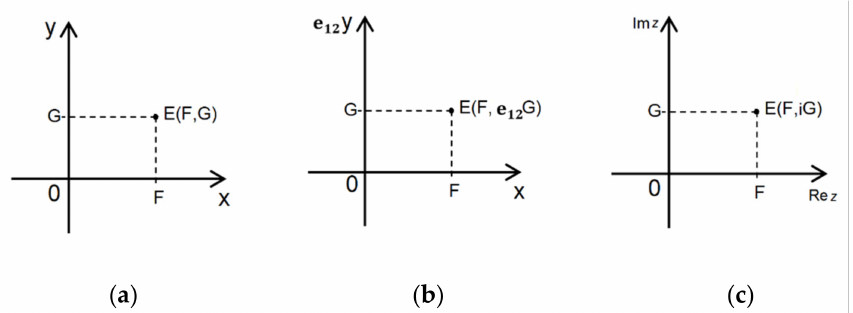
Figure 2. Various forms of representing a point in plane: ( a ) real plane with a matrix vector product; ( b ) vector plane with a geometric vector product; ( c ) complex plane with a dot product of complex